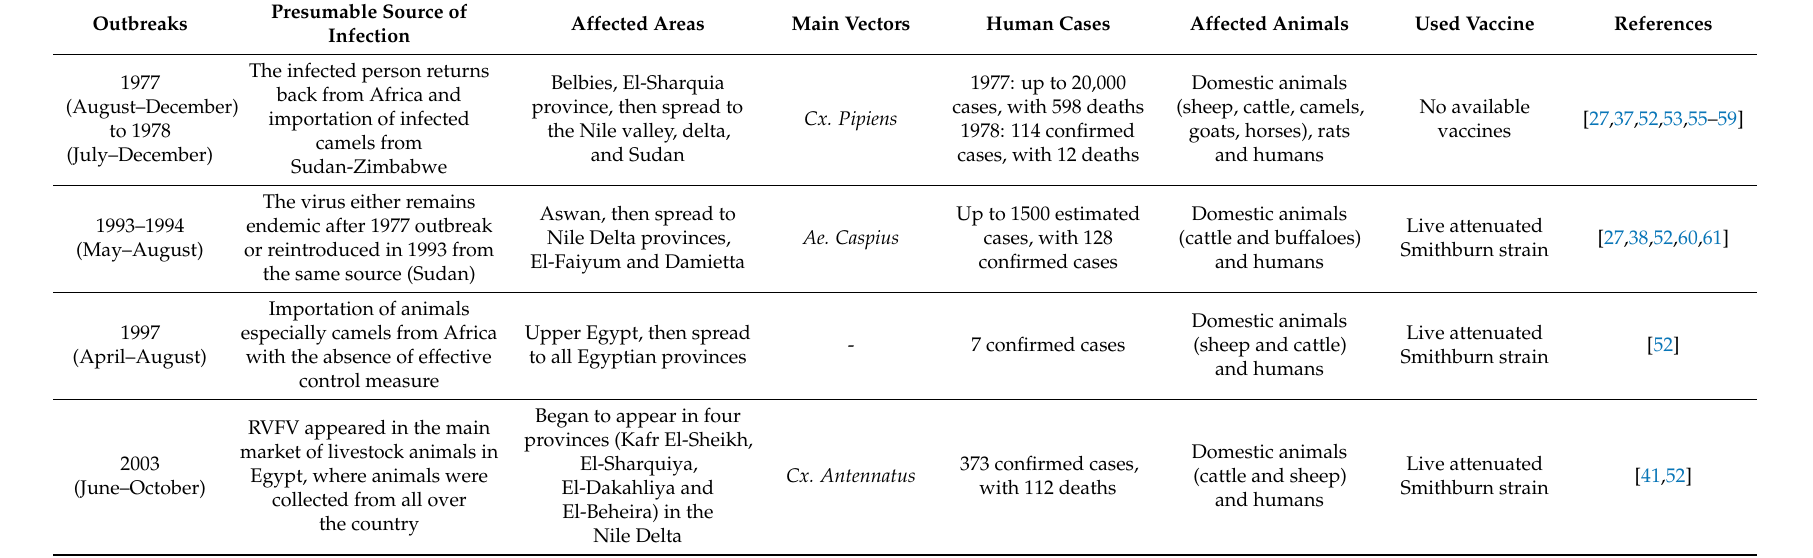
Table 1. Egyptian RVFV